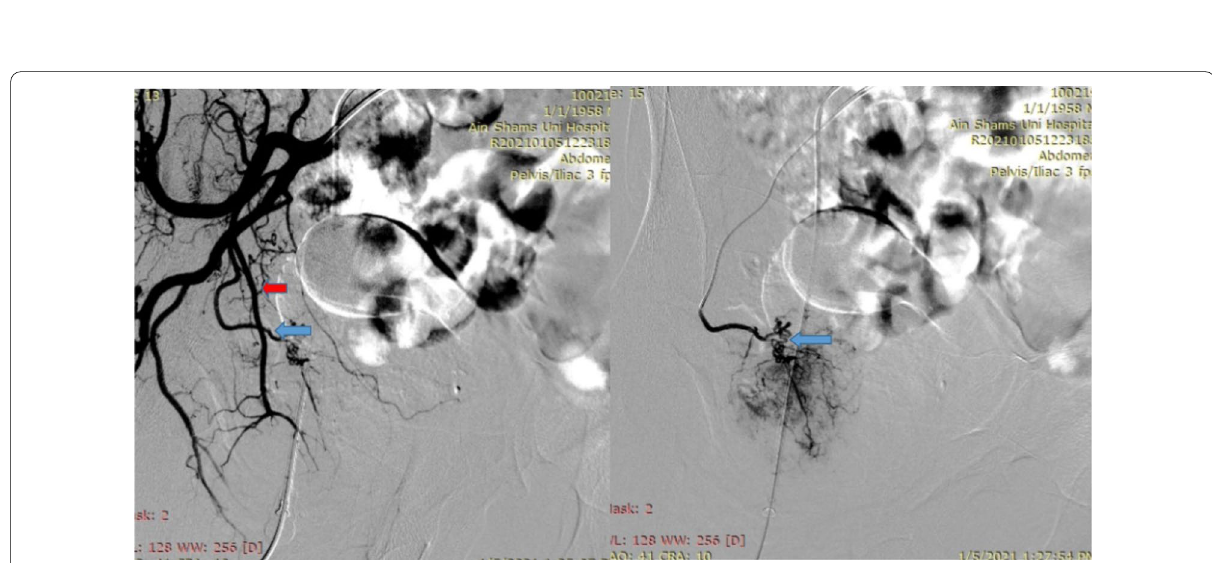
Fig. 6 Angiography images showing the origin of right prostatic artery (blue arrow) as a common origin with superior vesical artery (red